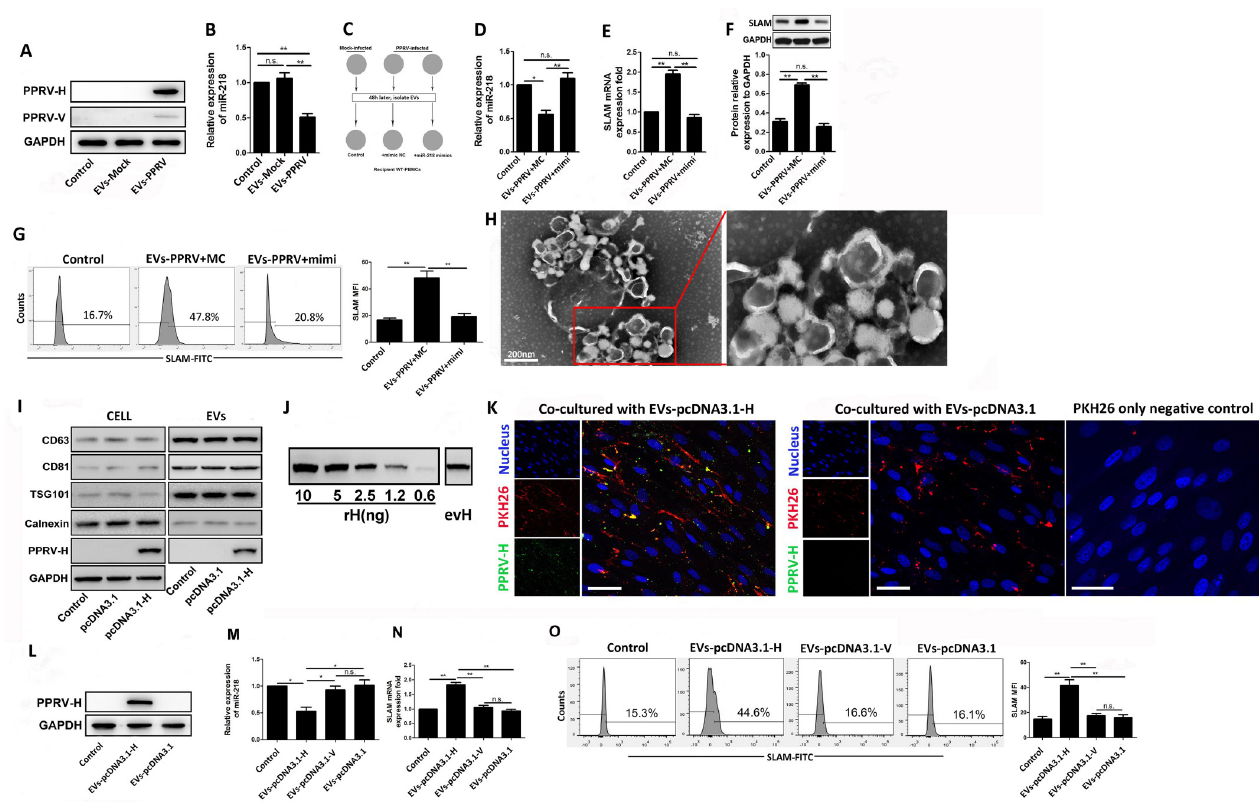
Fig 4. PPRV-H protein contained in extracellular vesicles is sufficient to regulate miR-218-mediated SLAM expression in the recipient cells. (A, B) Extracellular vesicles isolated from the supernatants of PPRV-infected (EVs-PPRV) and mock-infected goat PBMCs (EVs-Mock) were incubated with naive goat PBMCs, after 48 h, viral proteins and miR-218 expression levels in the recipient cells were detected by Western blot (A) and qRT-PCR (B), respectively. (C) Schematic presentation of the effects of PPRV-associated EVs on miR-218-mediated SLAM expression experiment. (D, E, F, G) Equal quantities of EVs- PPRV or EVs-Mock were co-cultured with the same amount of naive goat PBMCs pretransfected with either miR-218 mimic or control mimic (MC) for 48h. Untreated group of cells were used as control. Then, the expression of miR-218 (D) and SLAM mRNA (E) in the cells were analyzed by RT-qPCR, and SLAM expression was further detected by Western blot (F) and flow cytometry (G). (H) Transmission electron microscopy (TEM) analysis of EVs from goat PBMCs transfected with plasmids expressing PPRV H protein for 48 h.(I) Goat PBMCs were transfected with plasmids expressing PPRV H protein for 48 h, and then subjected to Western blot for the analysis of the expression of positive EVs marker CD63, CD81 and TSG101, and negative EVs marker Calnexin, as well as PPRV H in the cells and the isolated EVs, respectively. (J) Western blot for the indicated amounts of recombinant PPRV H (rH) and in a typical preparation of PPRV H-containing EVs (evH) (10 μ g of EVs protein). (K) EVs from goat PBMCs transfected with plasmids expressing PPRV H protein (EVs-pcDNA3.1-H) were labeled with PKH26 and incubated with naive goat PBMCs for 48 h, immunofluorescent staining was performed to analysis the expression of PPRV H protein (Scale bar = 30 μ m). (L, M, N, O) Goat PBMCs were incubated with EVs-pcDNA3.1-H, EVs-pcDNA3.1,or EVs from pcDNA3.1-V transfected cells (EVs-pcDNA3.1-V) for 48 h, and then subjected to Western blot for the analysis of the expression PPRV H protein (L), and the expression of miR-218 (M) and SLAM mRNA (N) were detected by RT-qPCR, and flow cytometry was performed to analyze SLAM expression on the surface of the cells (O). GAPDH was used as a loading control in RT-PCR and Western blot analysis. Data are given as means ± standard deviation (SD) from three independent experiments. P values were calculated using Student’s t test. An asterisk indicates a comparison with the indicated control. � , P < 0.05; �� , P < 0.01; n.s., not